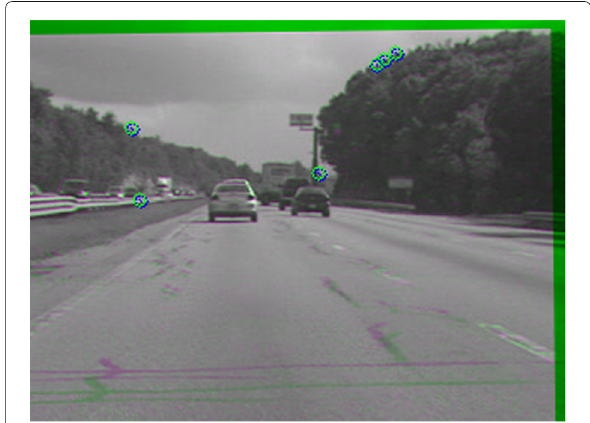
Fig. 5 Frame after application of geometric